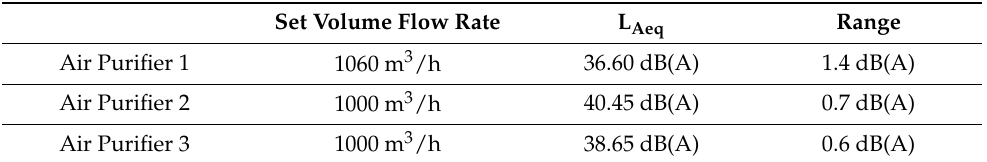
Table 3. Measured A-weighted equivalent continuous sound level L Aeq of the three tested air